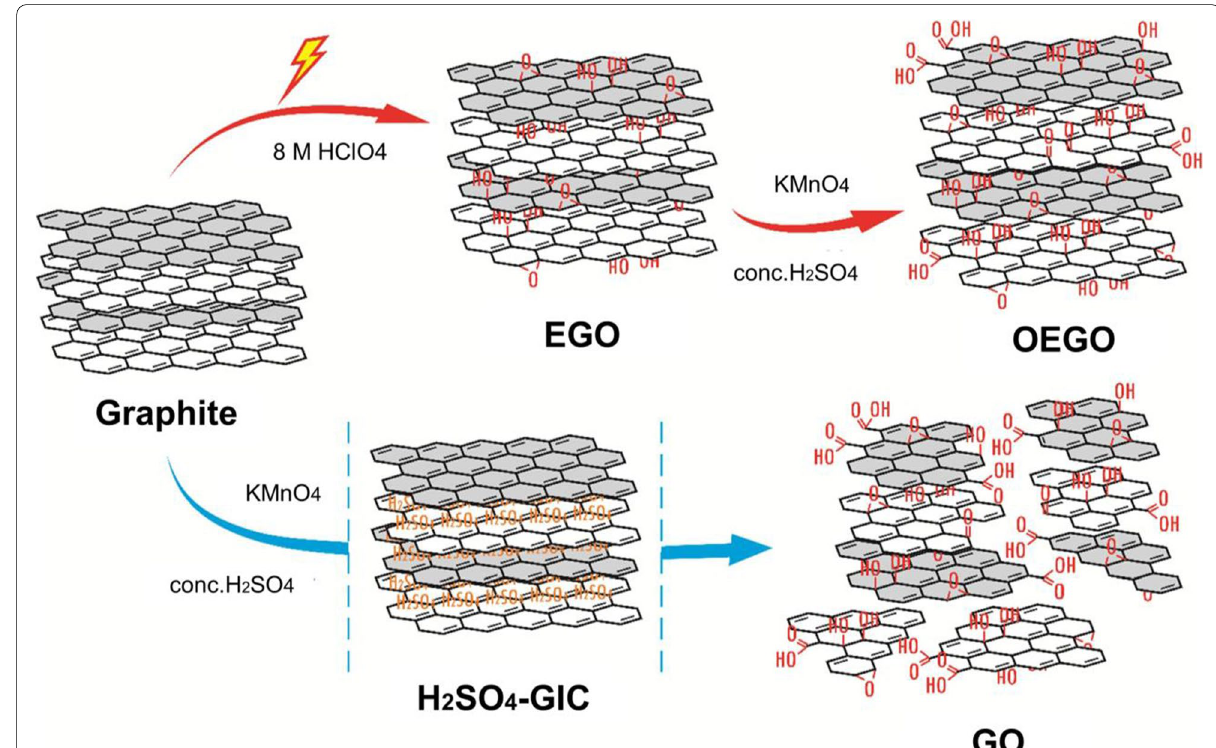
Fig. 2 Schematic illustration of electrochemically gathered graphite oxide (OEGO) synthesis. EGO and GIC are the electrochemically gathered GO and graphite intercalation compounds, respectively [68]. (Copyright 2017